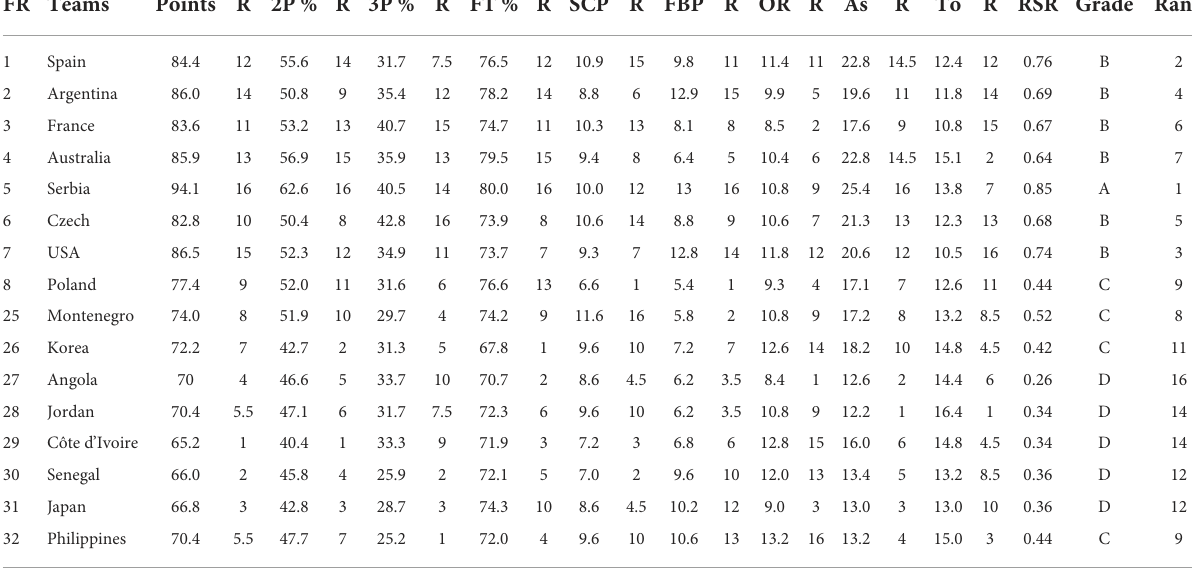
TABLE 2 The RSR values and grades of attacking performance for the top eight and bottom eight teams. FR Teams